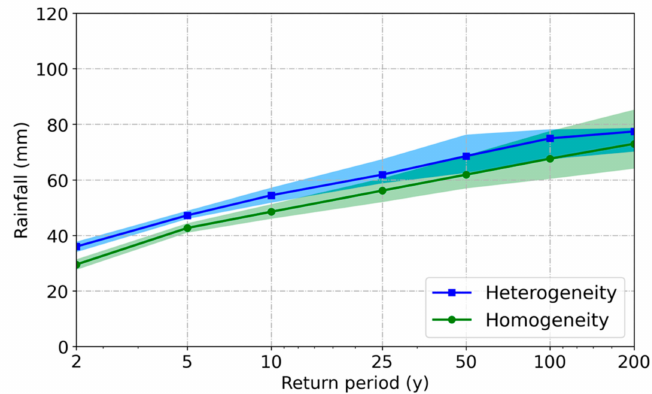
Figure 16. Comparison of Intensity-Duration-Frequency (IDF) curves uses non-uniform spatial transposition (heterogeneity) and uniform transposition (homogeneity) scenarios, which are calculated based on the SST method at a 3-h time scale. The blue / green areas indicate the spread of SST estimates with 90th and 10th quantiles as the solid